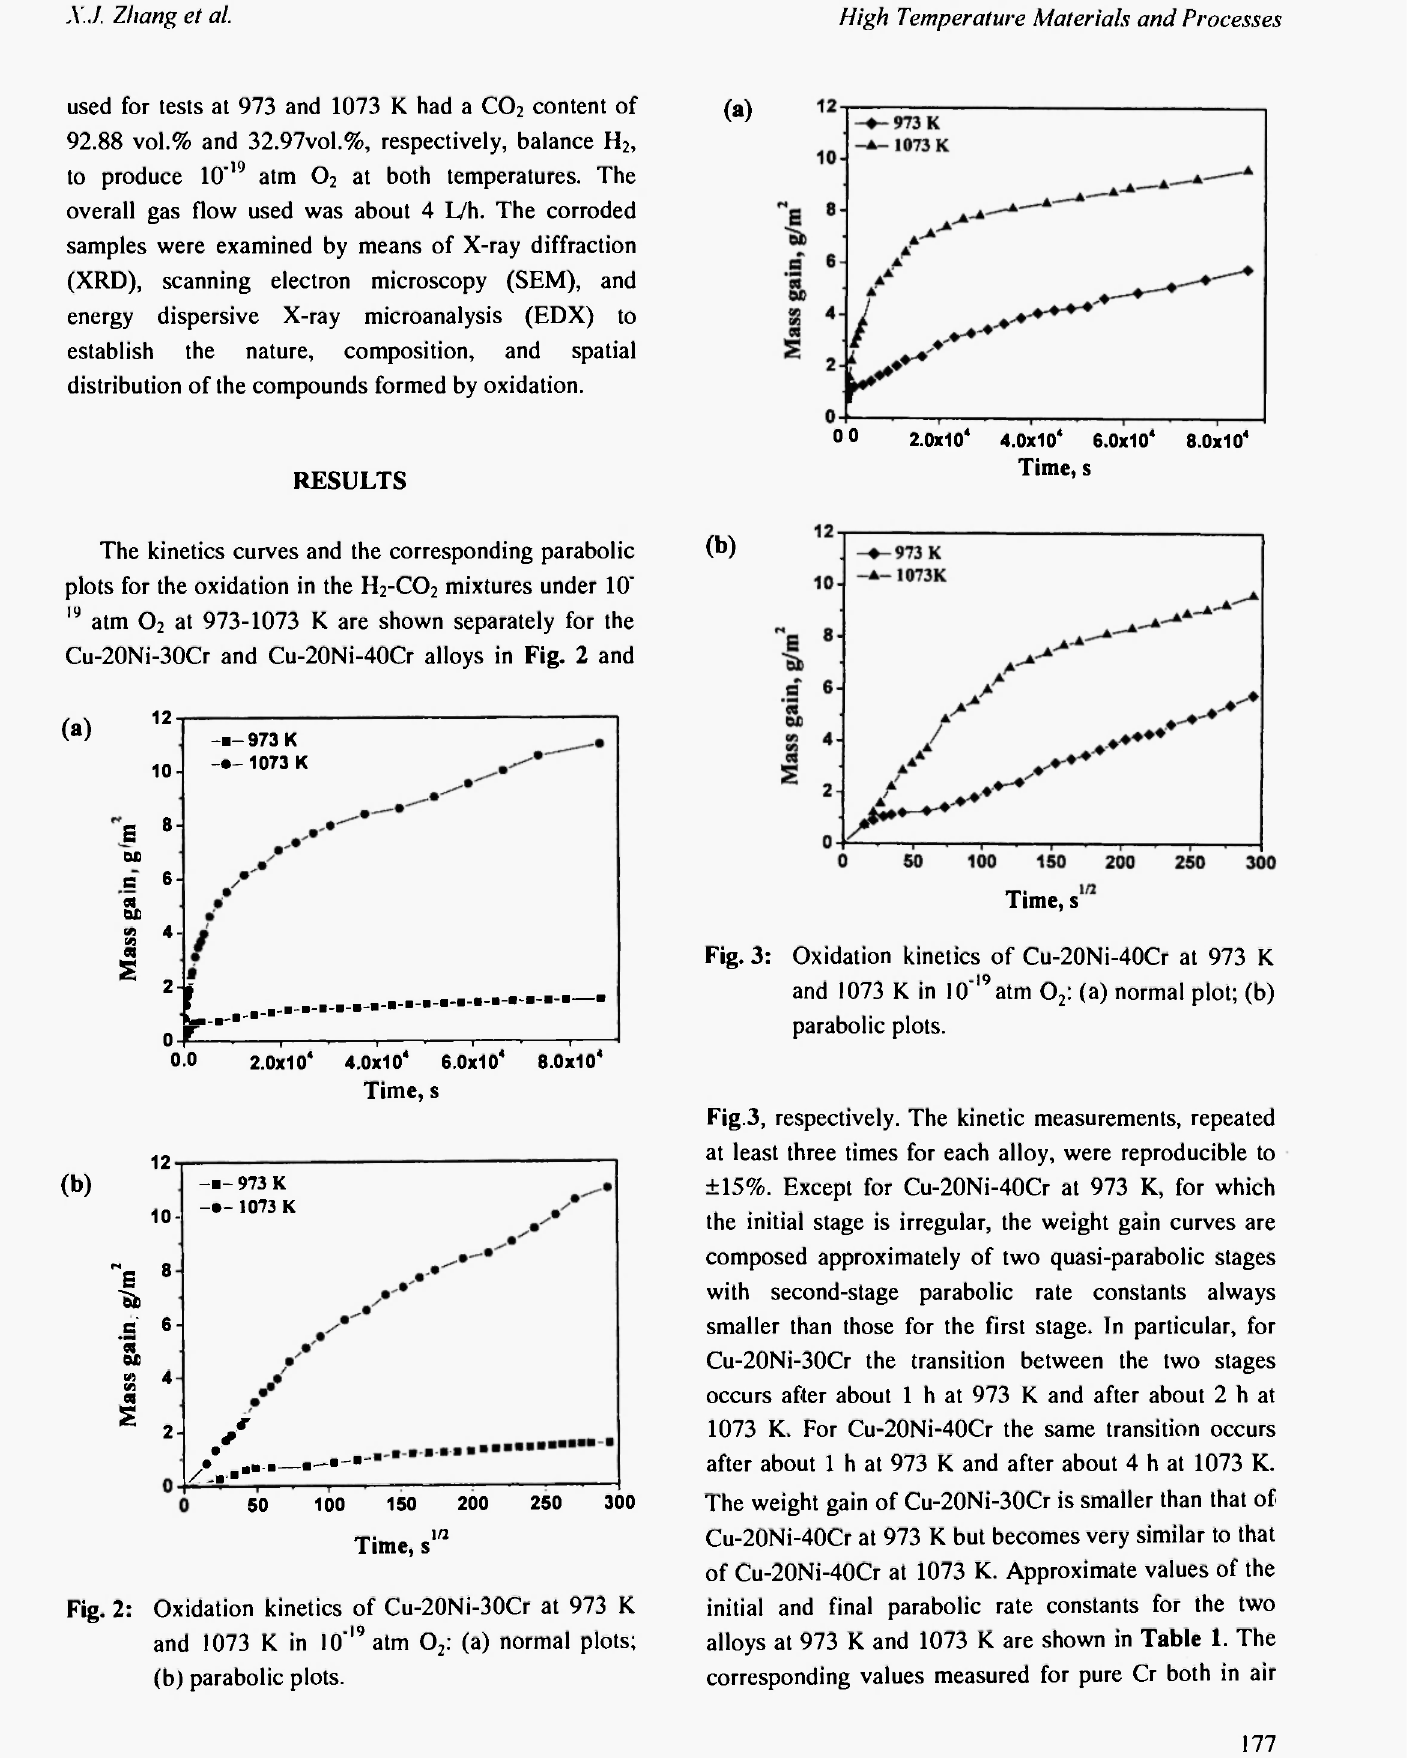
Fig. 2: Oxidation kinetics of Cu-20Ni-30Cr at 973 Κ and 1073 Κ in I0' l9 atm 0 2 : (a) normal plots; (b) parabolic plots.